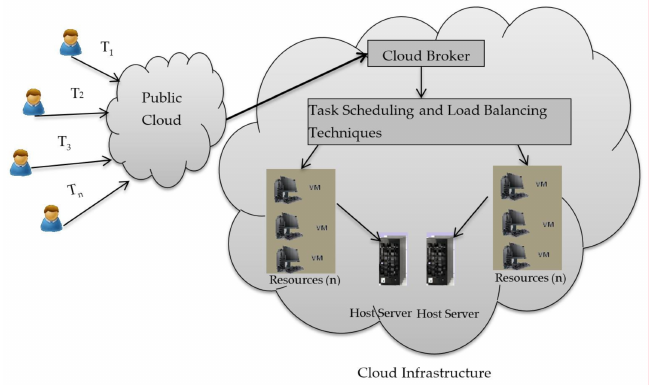
Figure 1. Cloud Infrastructure Bala